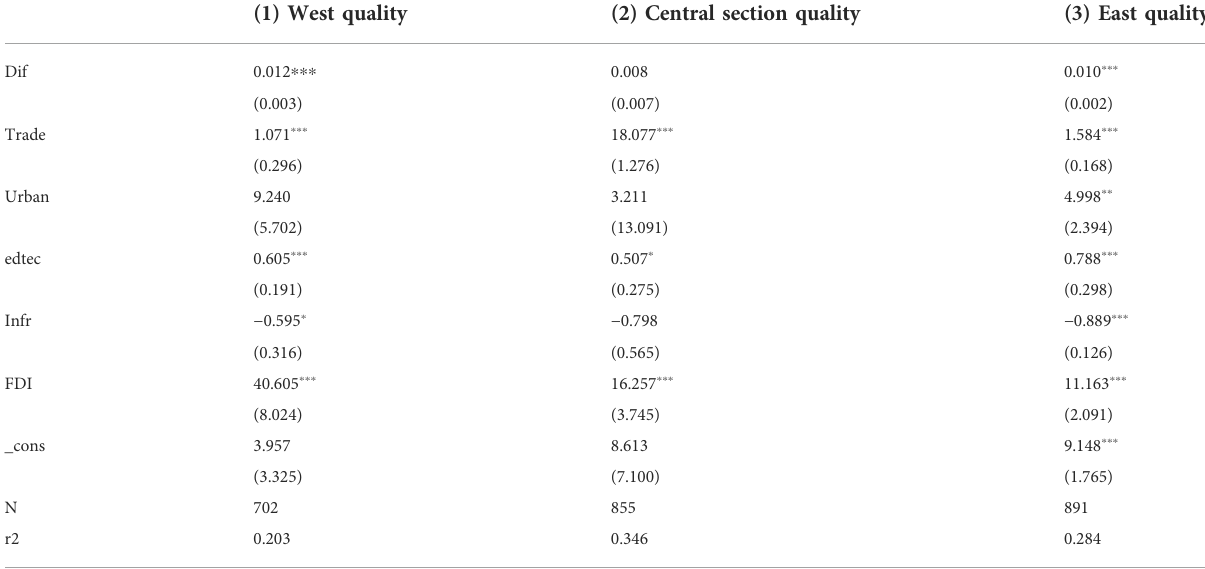
TABLE 5 Results of the regional heterogeneity test.